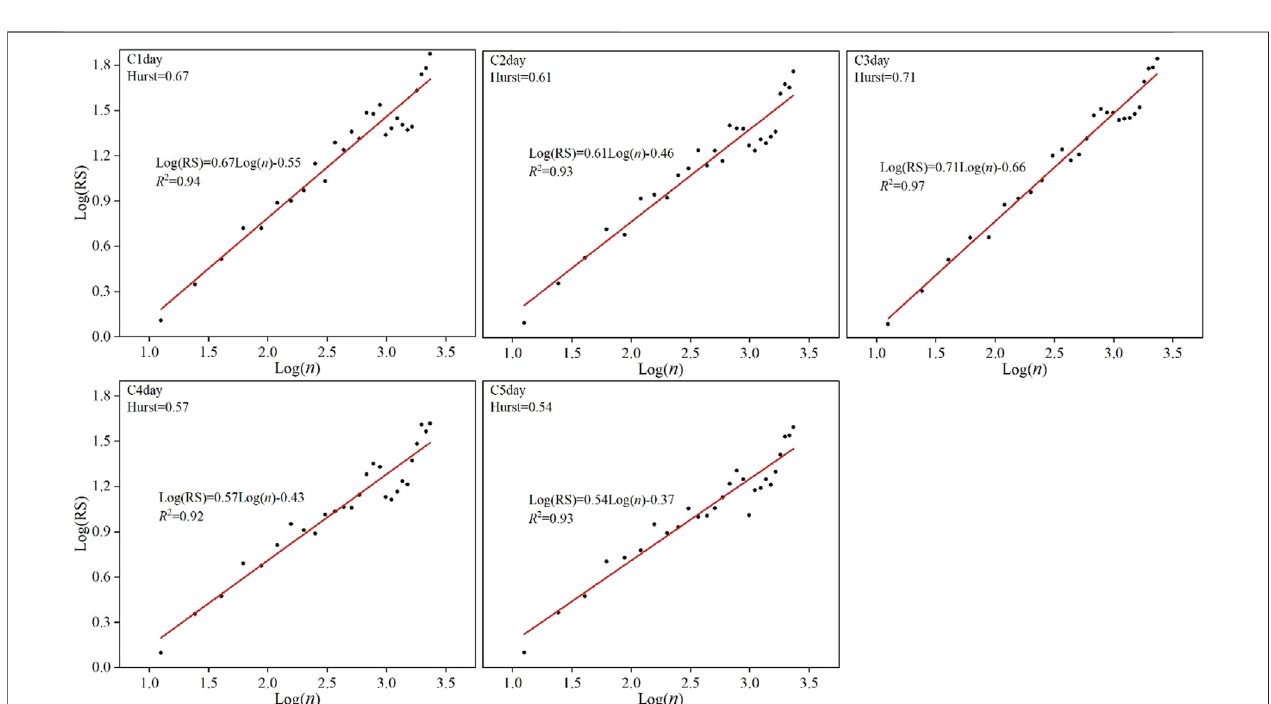
FIGURE 6 | Hurst long-range forecasting for the time series.